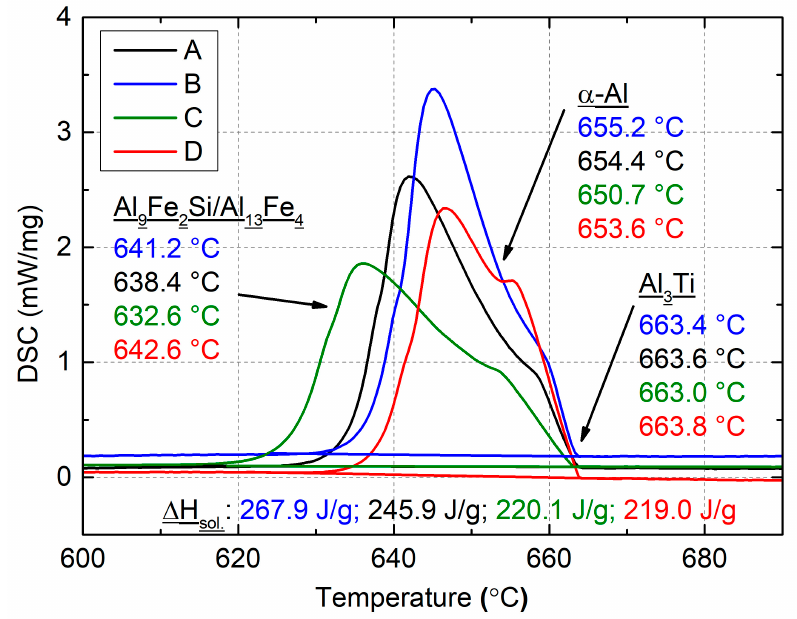
Figure 2. Cooling DSC curves of grain refiners investigated: A (black), B (blue), C (green), and D (red), with the characteristic temperatures, phases, and enthalpies marked.